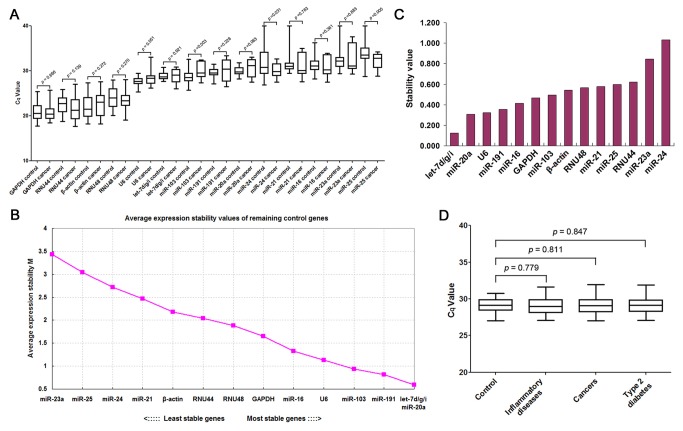
Validation of the stability of the selected reference genes by RT-qPCR assay.(A) Expression levels of candidate reference genes in serum. The expression levels of 14 candidates were measured by RT-qPCR in the sera from cancer patients (n = 21) and healthy controls (n = 35). The Cq values (median and range) of each miRNA were shown by box-and-whisker plots. Significance was calculated by t-test. (B) Identification of the optimal number of reference genes for accurate normalization using geNorm. (C) Identification of the most stable reference genes using NormFinder. (D) Expression levels of let-7d/g/i in large numbers of serum samples. The expression levels of let-7d/g/i were measured in the sera from healthy controls (n = 1278), cancer patients (n = 254), patients with inflammatory diseases (n = 200) and patients with type 2 diabetes (n = 320). The Cq values (median and range) in each group were shown by box-and-whisker plots. Significance was calculated by t-test.